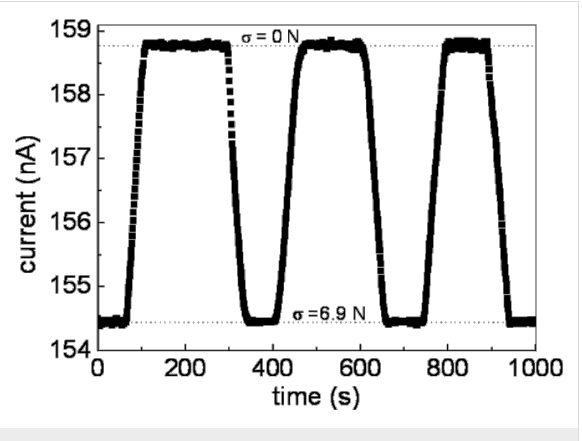
Figure 7: Time dependence of the electrical current for PMMA/ graphene. A constant voltage bias V = 5 V is applied to the sample while the applied force varies cyclically between unload ( F = 0 N) and load ( F = 6.9